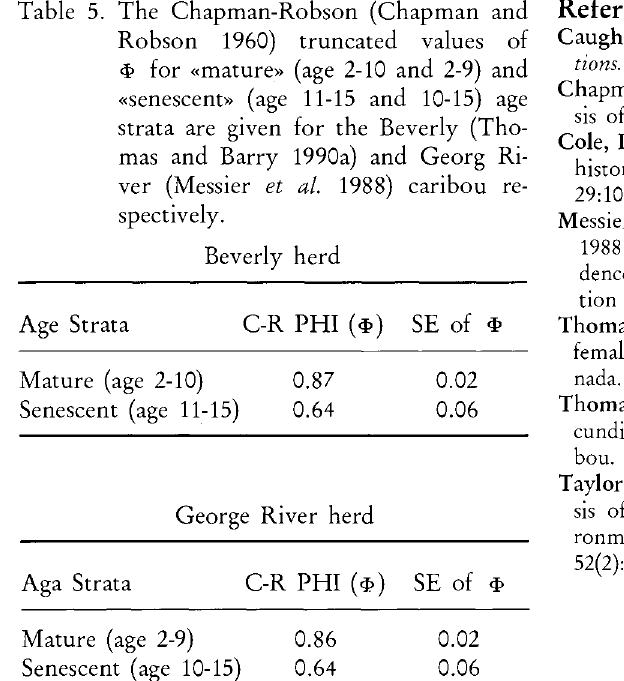
Table 5. The Chapman-Robson (Chapman and Robson 1960) truncated values